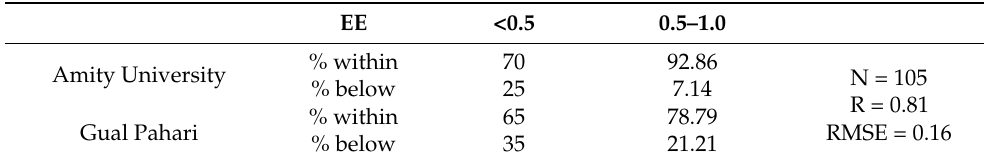
Table 2. Expected error envelope of AOD MAIAC in AOD bins of <0.5 and 0.5–1.0 (a) Amity University (b) Gual